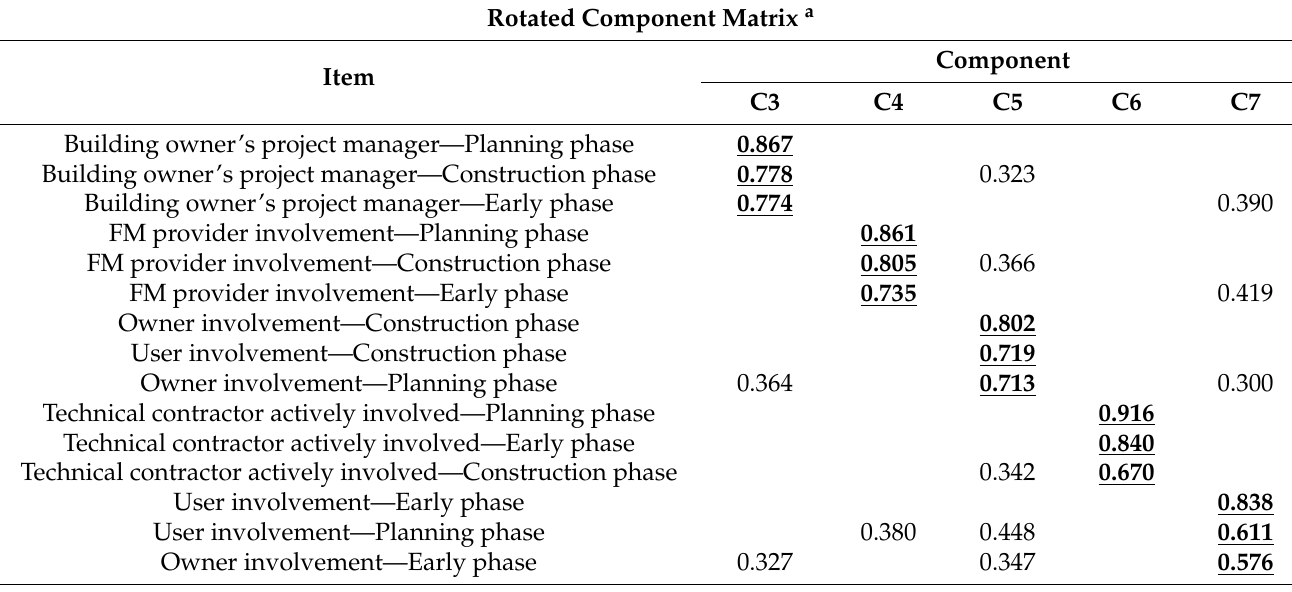
Table 4. Rotated component matrix—The project owner’s